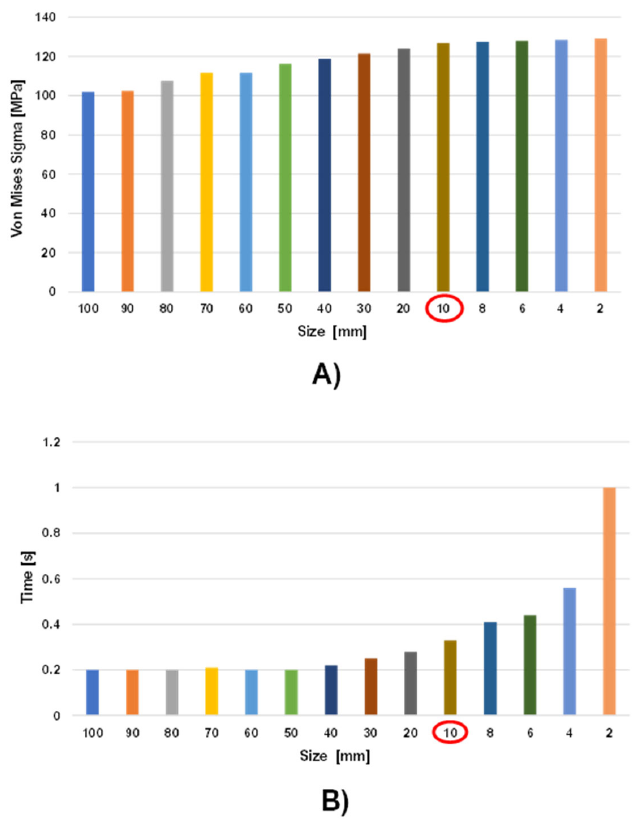
Figure 7. Finite element discretization. ( A ) Histogram graph of stresses as a function of element size; ( B ) Histogram graph of calculation time as a function of element size.